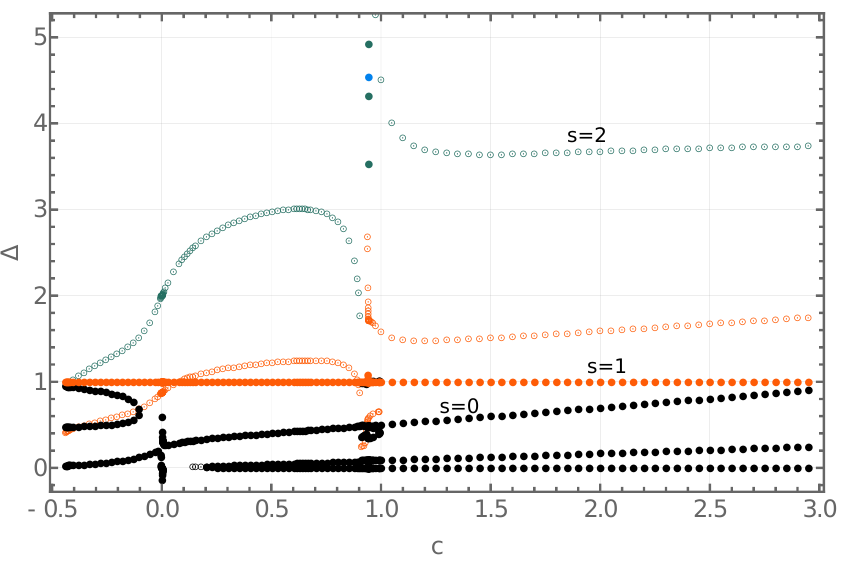
Figure 4 . Roots of the extremal functional evaluated at decreasing values of the central charge. Single roots are denoted by filled circles and double roots are denoted by dotted